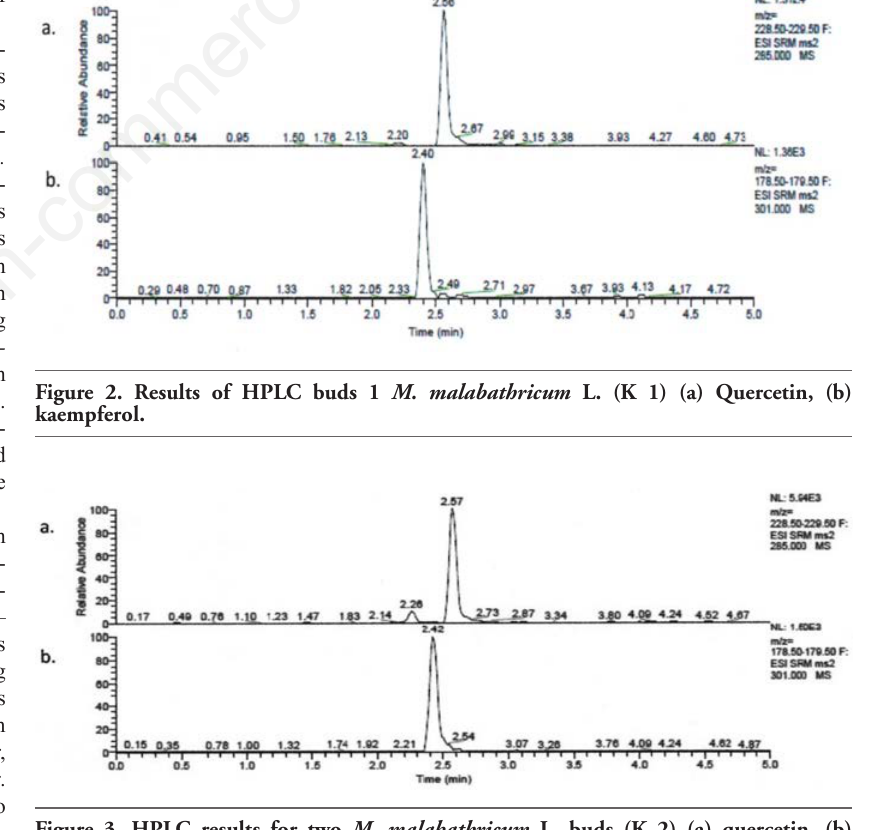
Figure 3. HPLC results for two M. malabathricum L. buds (K 2) (a) quercetin, (b)